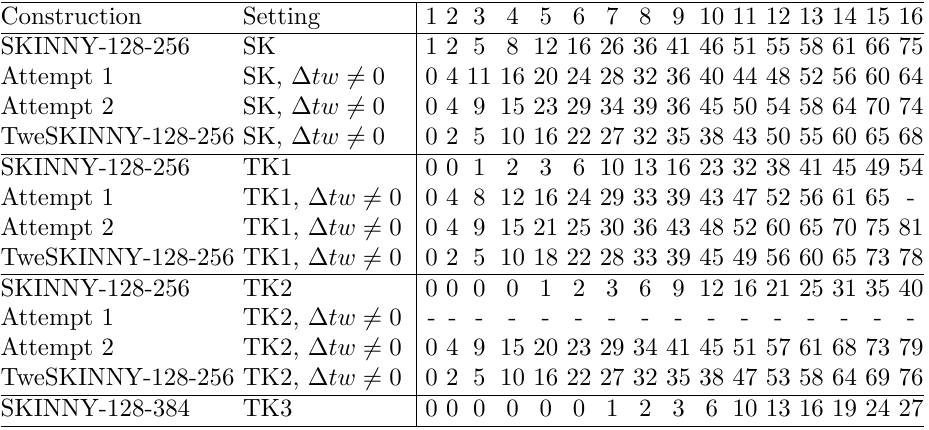
Table 3: Comparison of the Minimum Number of Active